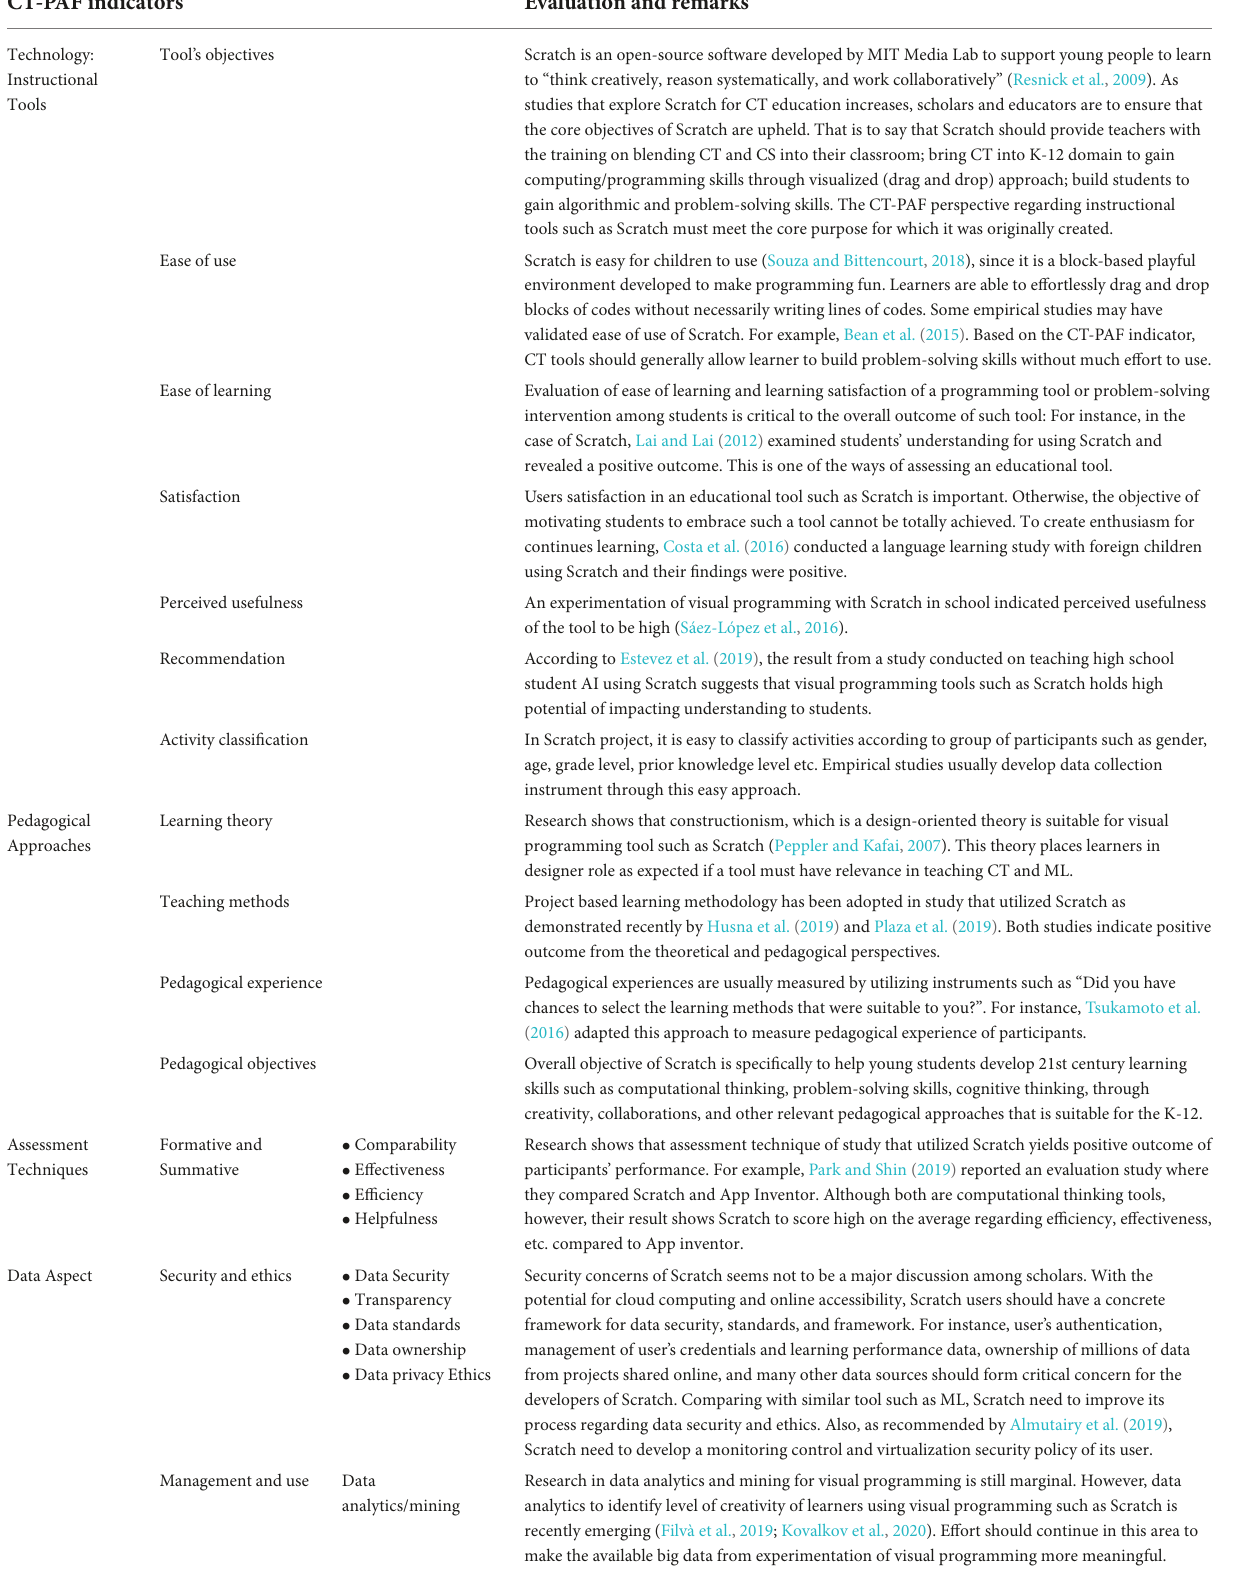
TABLE 3 Evaluation of Scratch based on